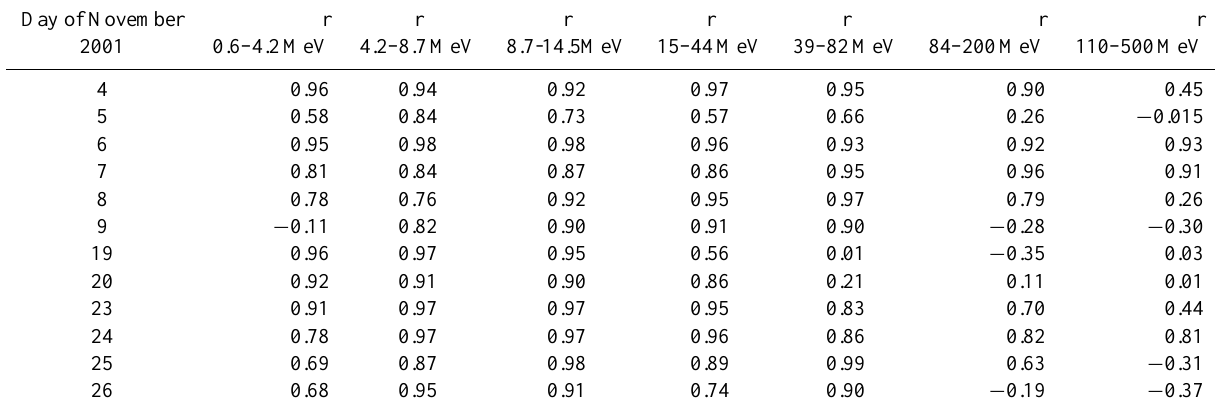
Table 2. Daily correlation coefficients between A and J 1 / 2 for each differential protons flux energy